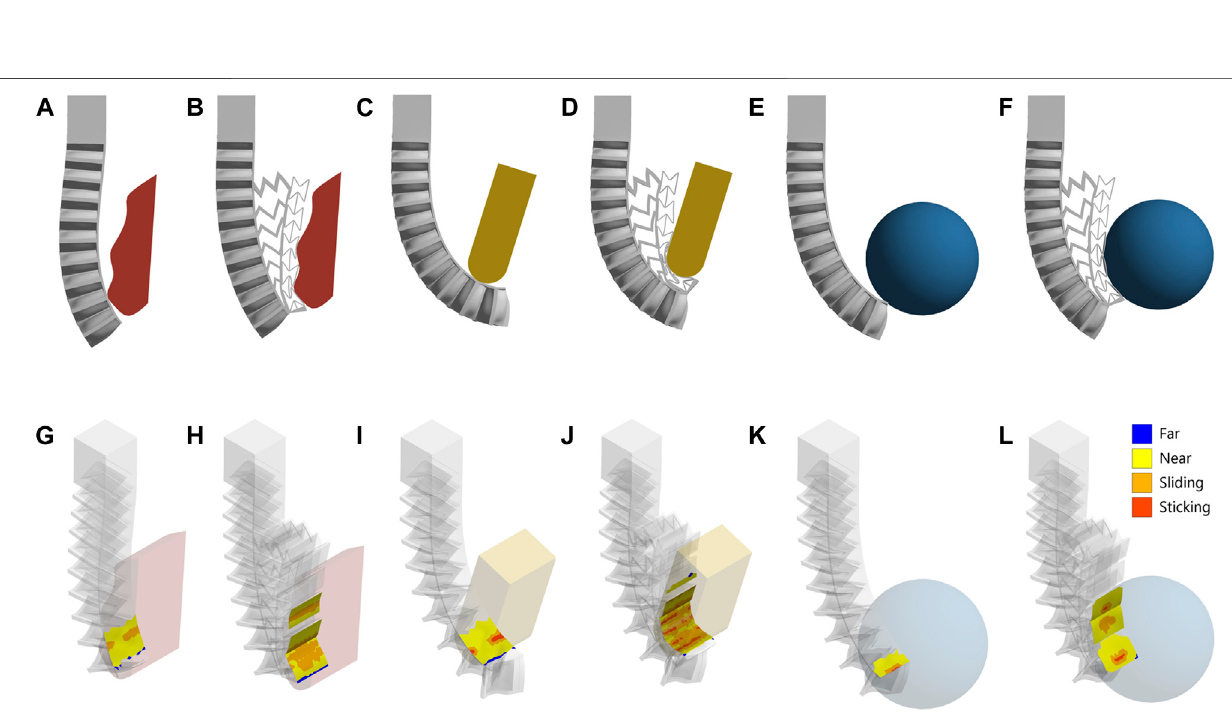
FIGURE 6 | 3D printed soft monolithic fi nger FEM contact simulations. The soft fi nger without and with the mechanical metamaterial in contact with (A) and (B) an irregularshape, (C) and (D) abarwitharoundedtip,and (E,F) asphere. (G – L) Thesoft fi nger,withoutandwiththemechanicalmetamaterial,contactstatusineachofthe correspondingcases.Forthecontactlegend, “ Far ” meansthereisnocontact atallbetweenthesurfaces, “ Near ” meansthatthesurfaceshave normalseparationwithin apinballradius, “ Sliding ” meansthatthesurfacescansliderelativetoeachother,and “ Sticking ” meansthatthereisnomovementbetweenthesurfacesincontact.